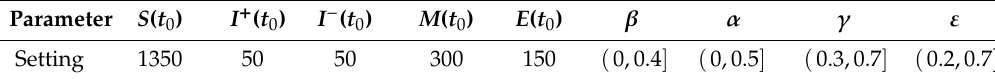
Table 3. Experimental parameter setting.